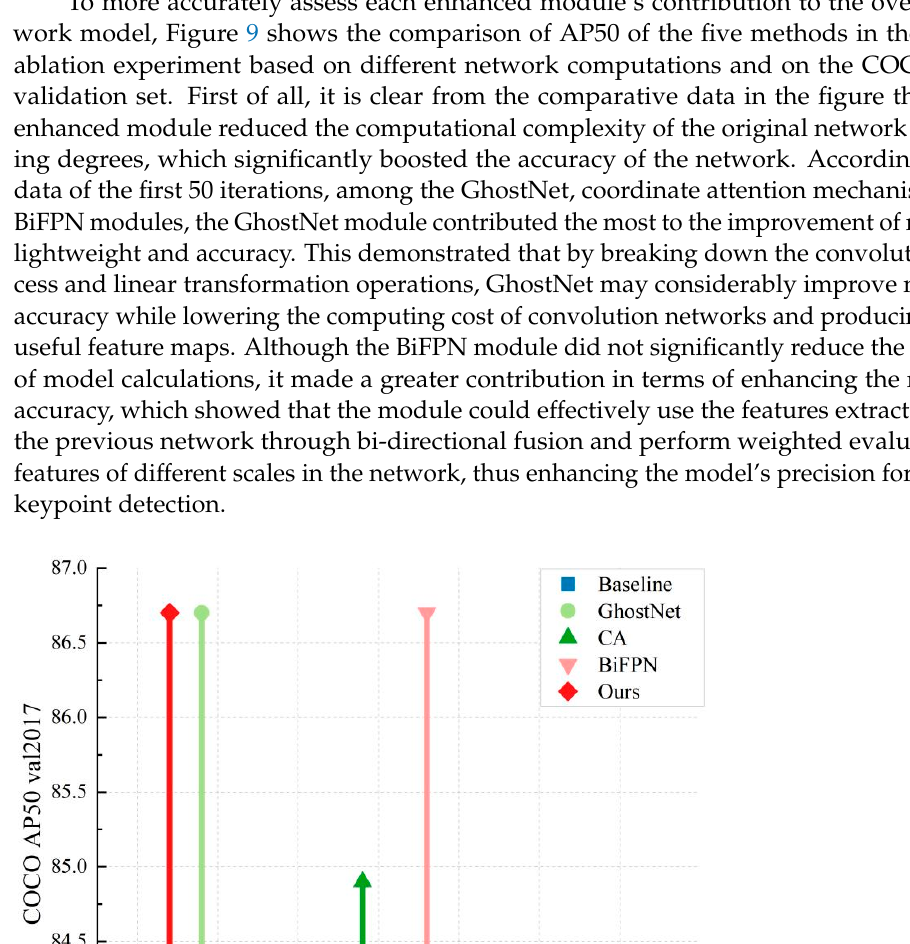
Table 5. Ablation Experiment Configuration and Results. √ and - denotes “with” and “without” the module respectively.